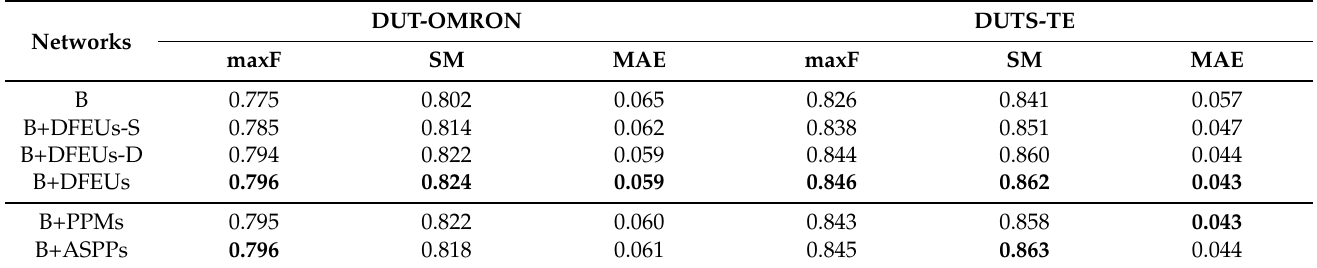
Table 3. Ablation analysis on the efficiency of the DFEU module. “B” refers to the baseline network, and “DFEUs-S” and “DFEUs-D” indicate DFEU modules of the same size with (3 × 3) kernels and with different large kernels. “B+DFEUs” indicates channel shuffling after “B+DFEUs-D”. The PPM and ASPP modules were compared by replacing the DFEU module. The best results are in bold.